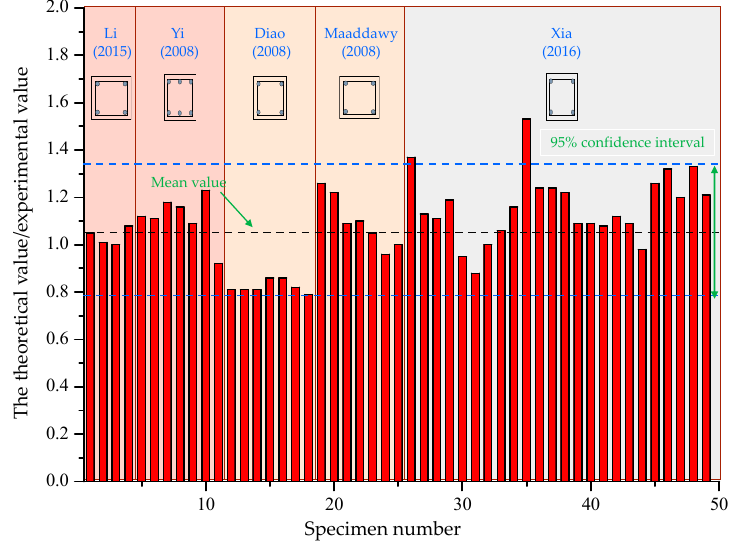
Figure 6. Comparison between the predicted values and experimental data.